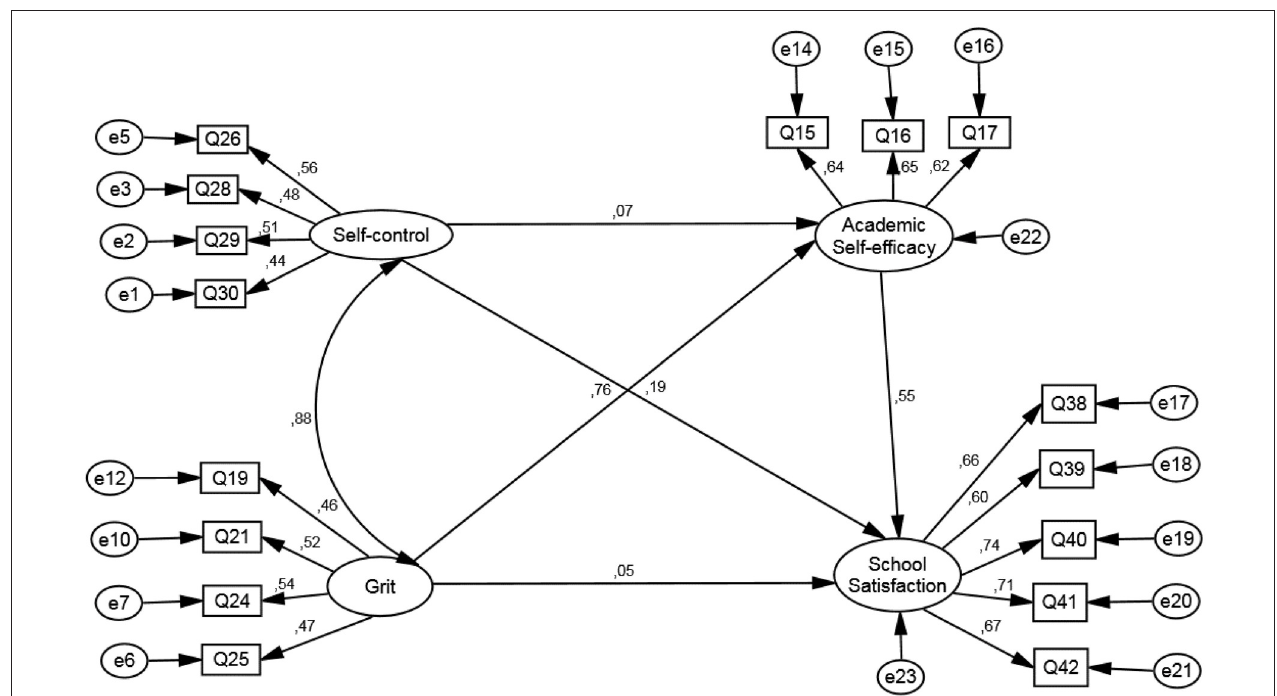
FIGURE 1 | Structural equation modeling for primary students.